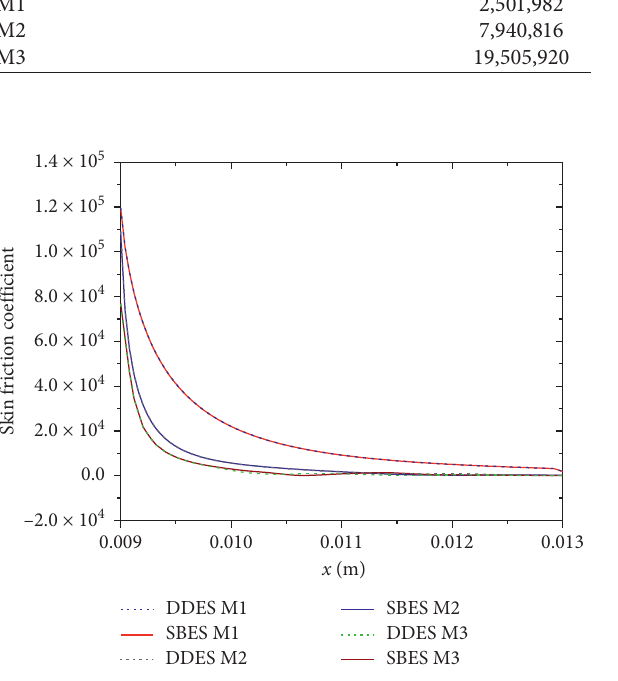
Figure 4: Skin friction coefficient on the surface of the nozzle divergent